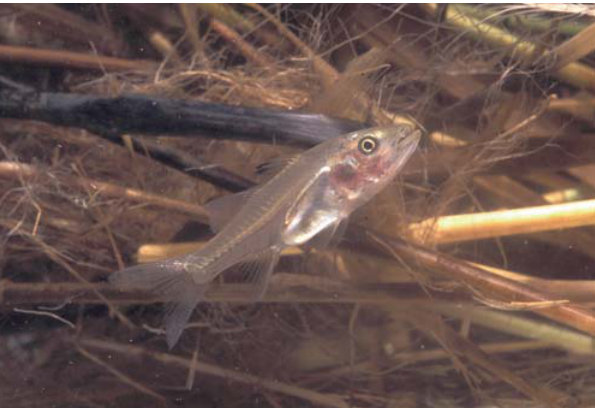
Fig. 5. A juvenile Centropomus mexicanus (12.9 mm SL, ZUEC 6171) gorged with eleotrid fish prey, photographed in field aquarium under artificial